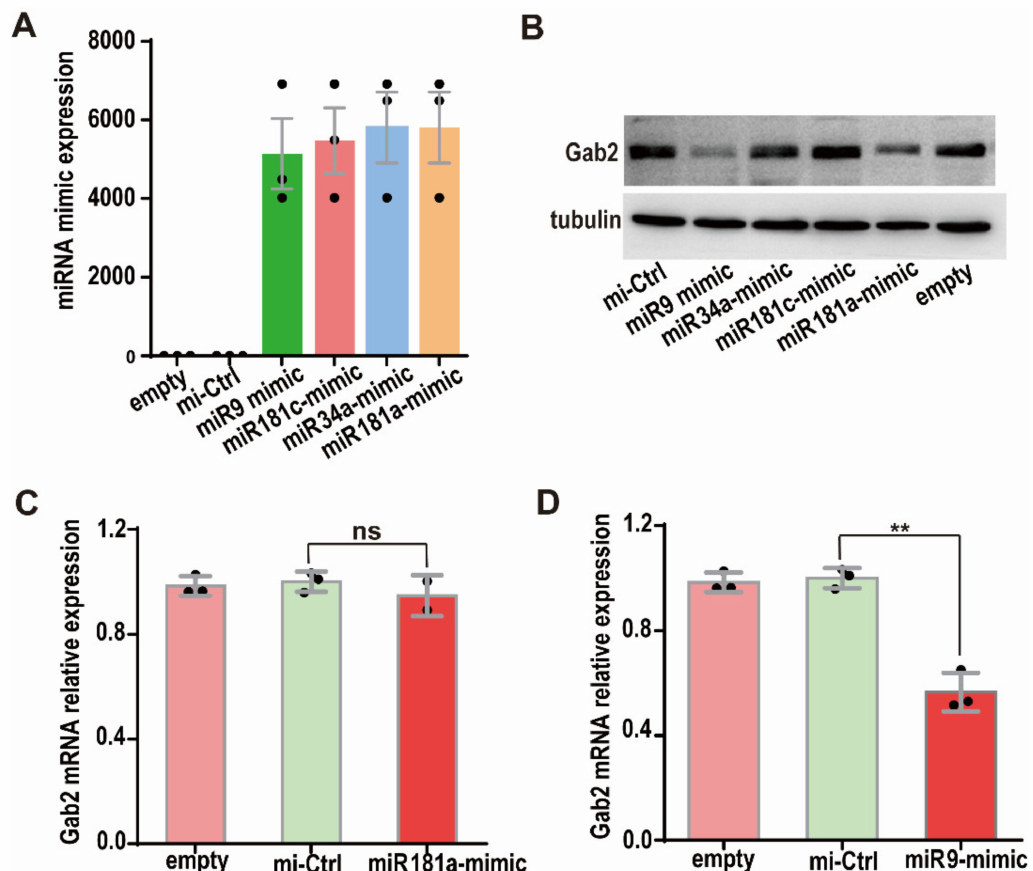
Figure 2. Effect of miRNA mimics transfection on Gab2 protein expression. ( A ) Expression of miRNA mimics. ( B ) Effects of four miRNA mimics on Gab2 protein expression, as checked by Western blotting. Tubulin was used as a total protein control. ( C , D ) Effects of hsa-miR-9 mimic and hsa-miR- 181a mimic on Gab2, mRNA expression, as analyzed by RT-PCR. Empty: nontransfected; mi-Ctrl: mimic negative control. The results are presented as the means ± SDs. Statistical comparisons of values were made using Student’s t -test. ns, nonsignificant; ** p <